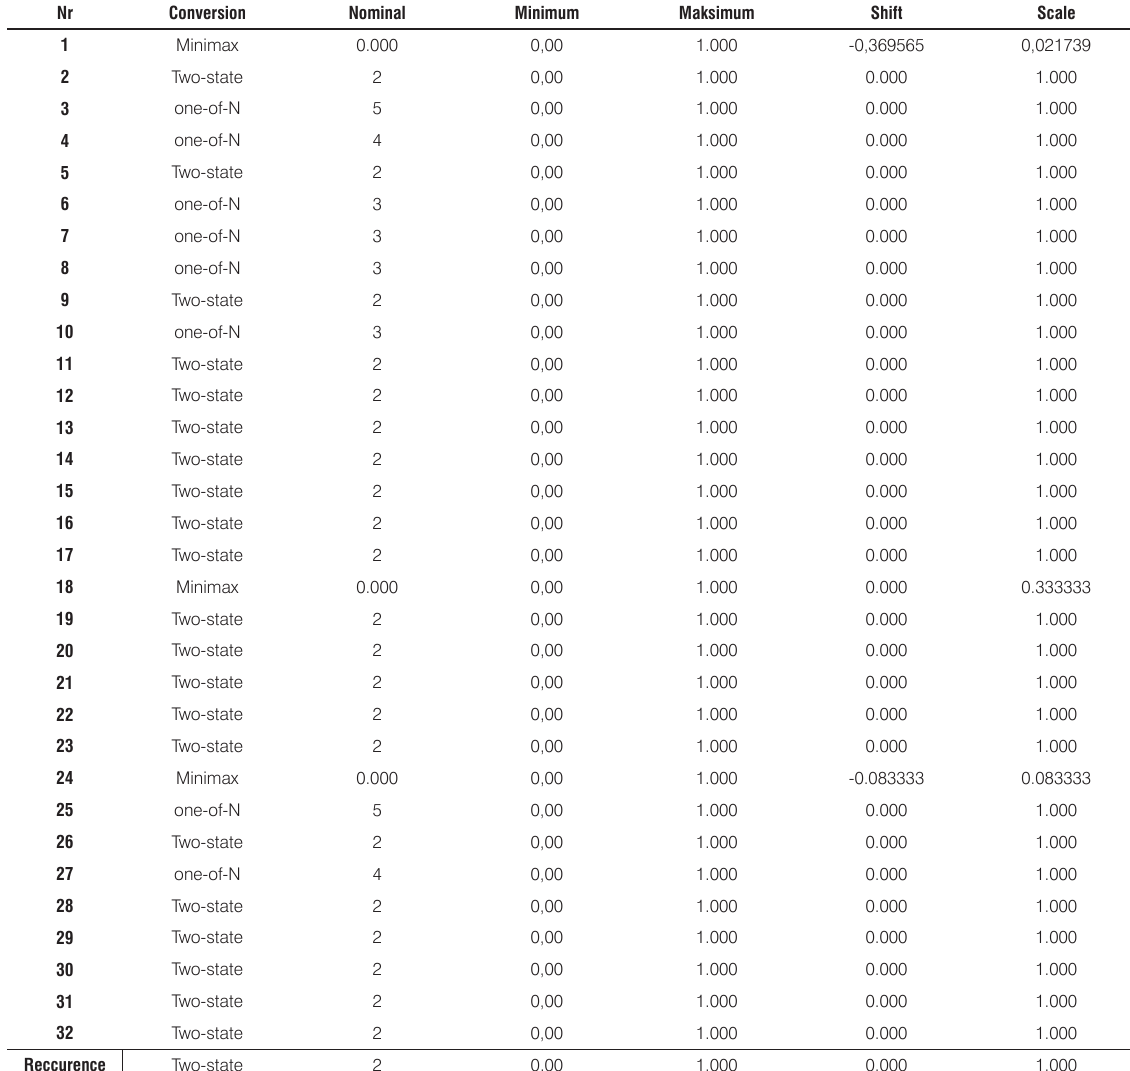
Table 2. Coding and preprocesing of variables for ANN